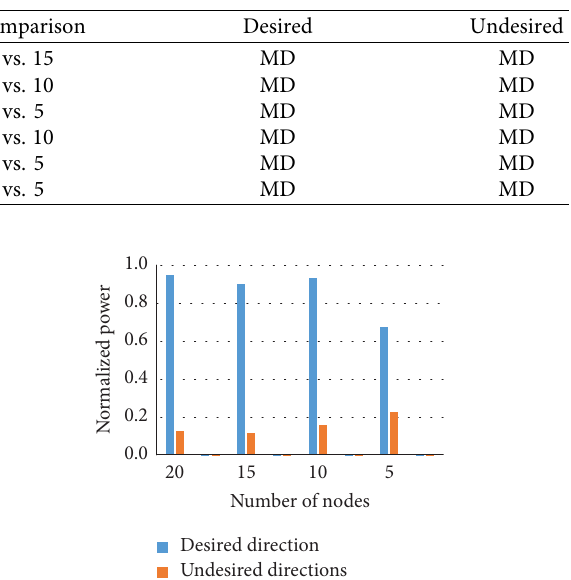
Table 14: Tukey–Kramer comparison test. MD means diferent. MnD means not